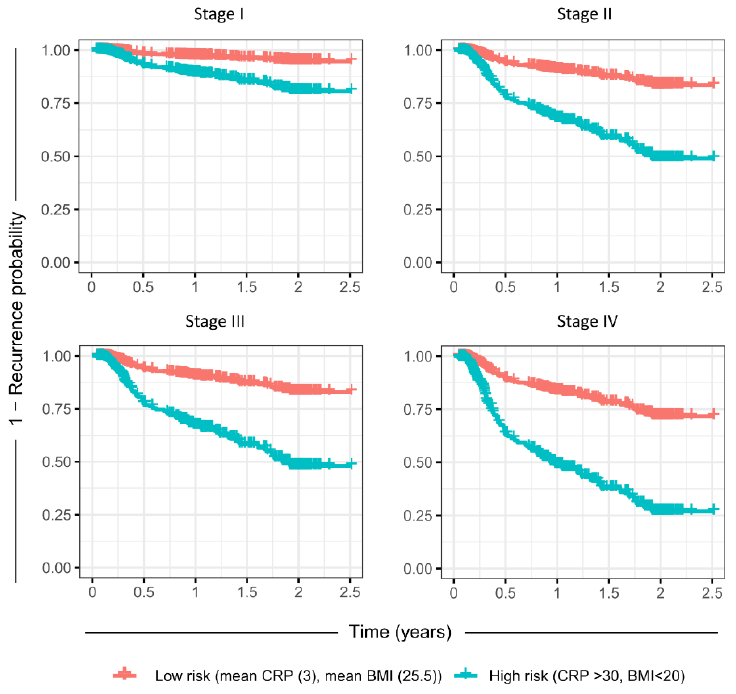
Figure 4. Predicted recurrence probability from the reduced Cox regression model with only signif- icant factors included. Red indicates the mean of the study population (mean CRP, mean initial BMI) and blue indicates the higher risk population (CRP > 30, initial BMI < 20). The sex factor is set at average risk for males/females.